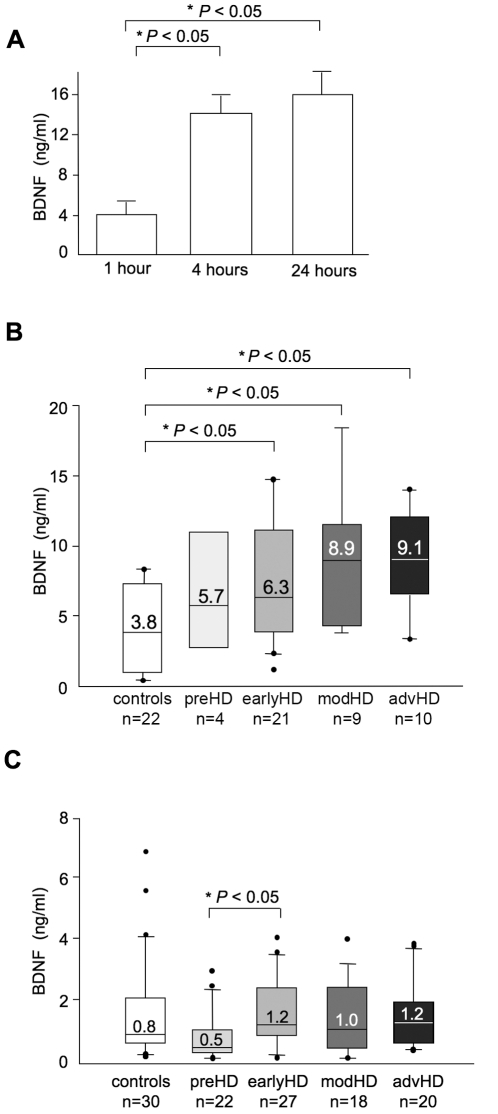
BDNF protein in human plasma measured by ELISA.(A) BDNF content in plasma samples from 3 control subjects. After blood withdrawal, samples remained at RT for 1, 4, and 24 hours before the plasma was isolated (p<0.05 compared to sample processed after 1 hour, unpaired t-test). (B) BDNF protein levels in plasma samples from the French Cohort, prepared 4 hours after blood withdrawal. Control and HD subjects exhibited a large variability in plasma BDNF levels. Values inside the boxes are the medians for the group. P<0.05, controls vs early HD, P<0.05 controls vs moderate HD and P<0.05 controls vs advanced HD, according to Kruskal-Wallis test followed by Dunn's multiple comparison test (C) BDNF protein contents in plasma samples from UK Cohort A, prepared 2 hours after blood withdrawal. BDNF protein in preHD was significantly lower than that in early HD, P<0.05 according to Kruskal-Wallis test followed by Dunn's multiple comparison test.